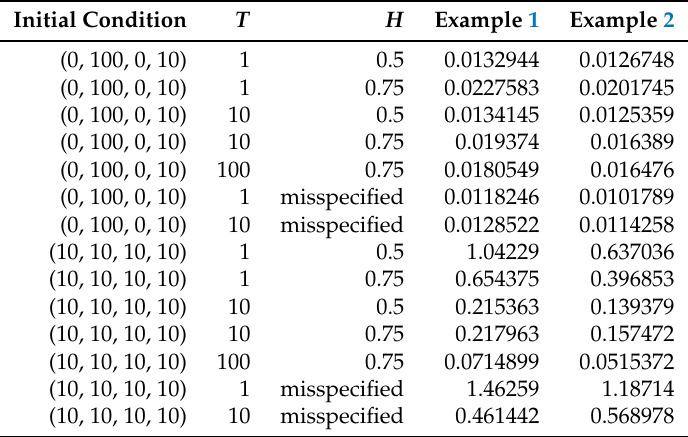
Table 1. RMSE of the calculated estimates using 100 samples with λ =